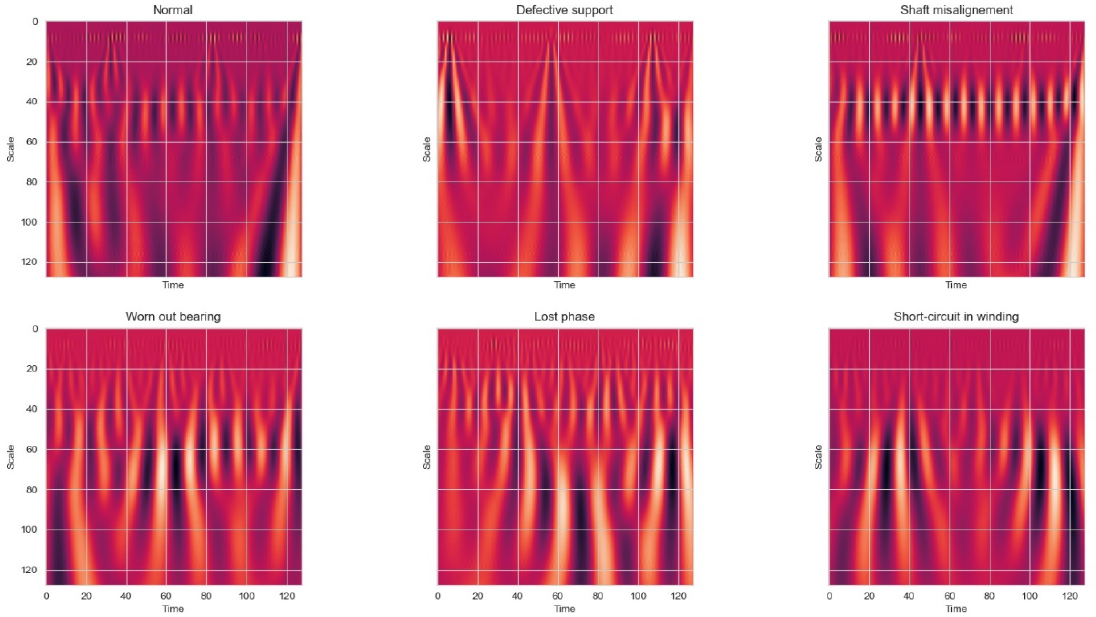
Figure 6. One sample of resulting scalograms with all six classes.